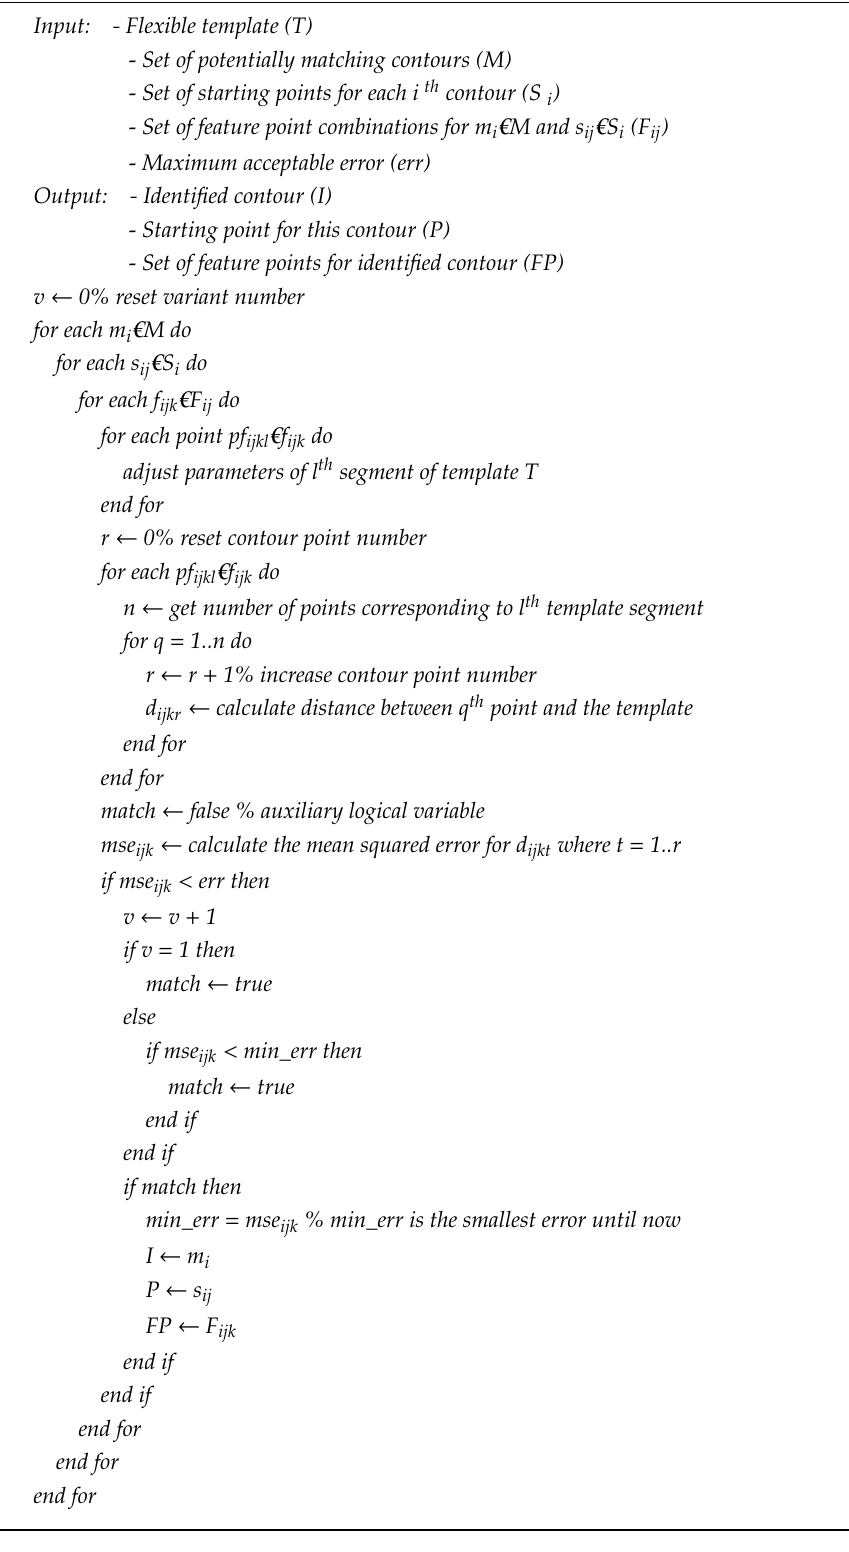
Algorithm 2 Detailed